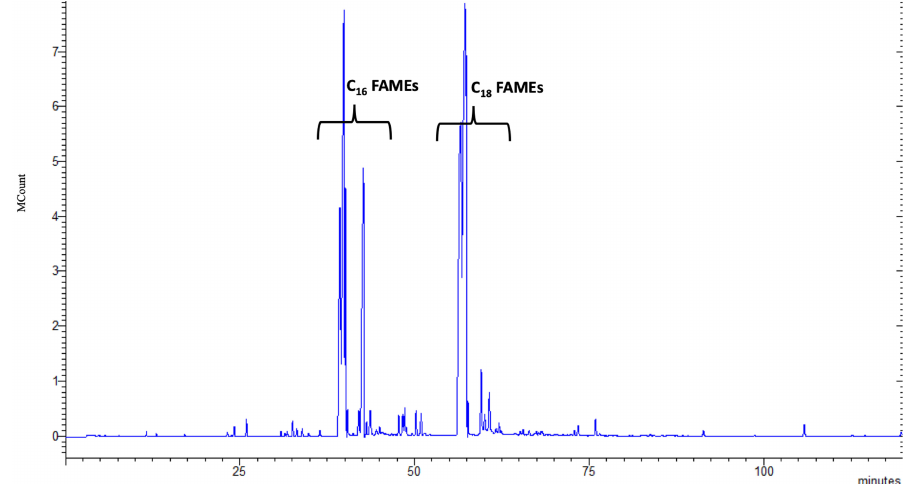
Figure 2. Total ion chromatograms of fatty acids methyl esters (FAMEs) from the total lipid fraction (TL) of Chlorella sorokiniana